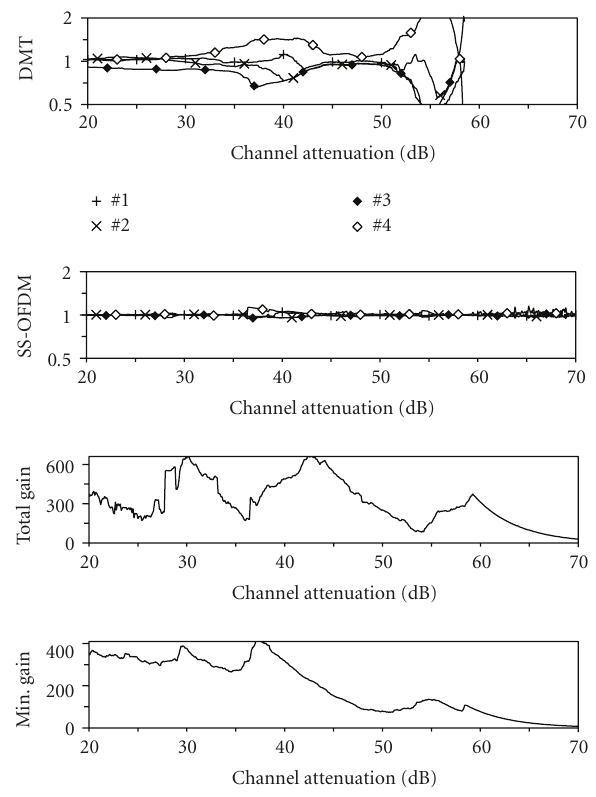
Figure 13: Relative throughput dispersion per user for DMT and SS-OFDM, total throughput gain, and gain of minimum user’s throughput of SS-OFDM compared to DMT, versus channel atten-